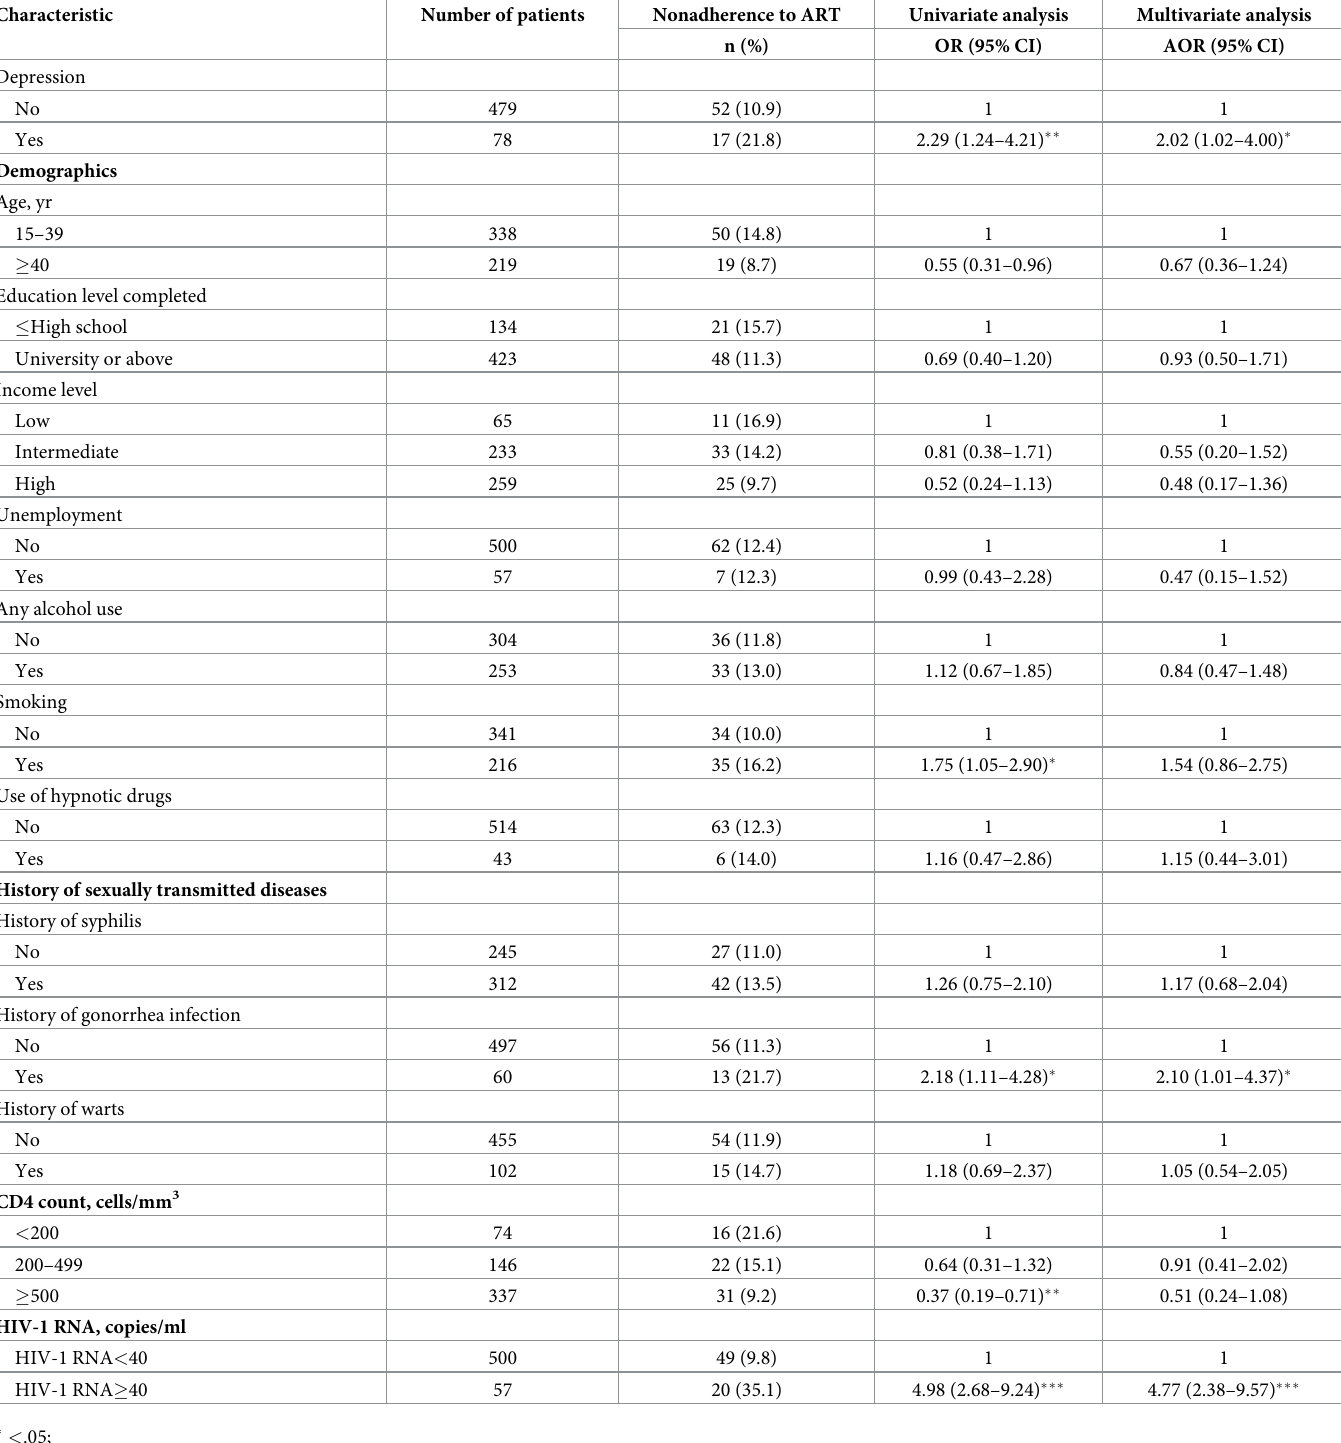
Table 2. Univariate and multivariate analyses of the factors associated with non-adherence to antiretroviral therapy among HIV-infected